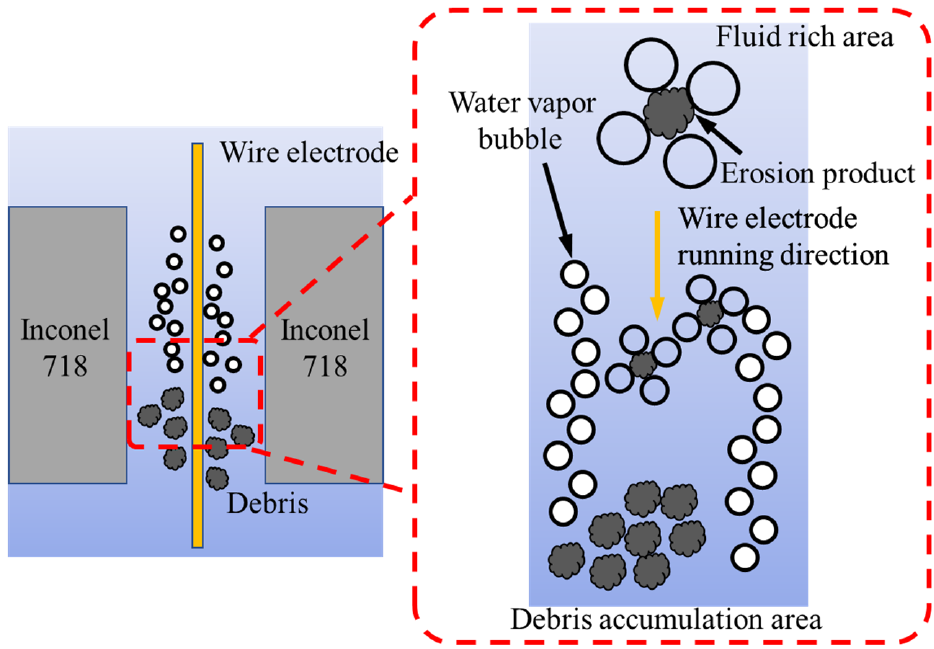
Figure 10. The cutting mechanism affecting process efficiency through spark generation, debris re- moval, and discharge gap.